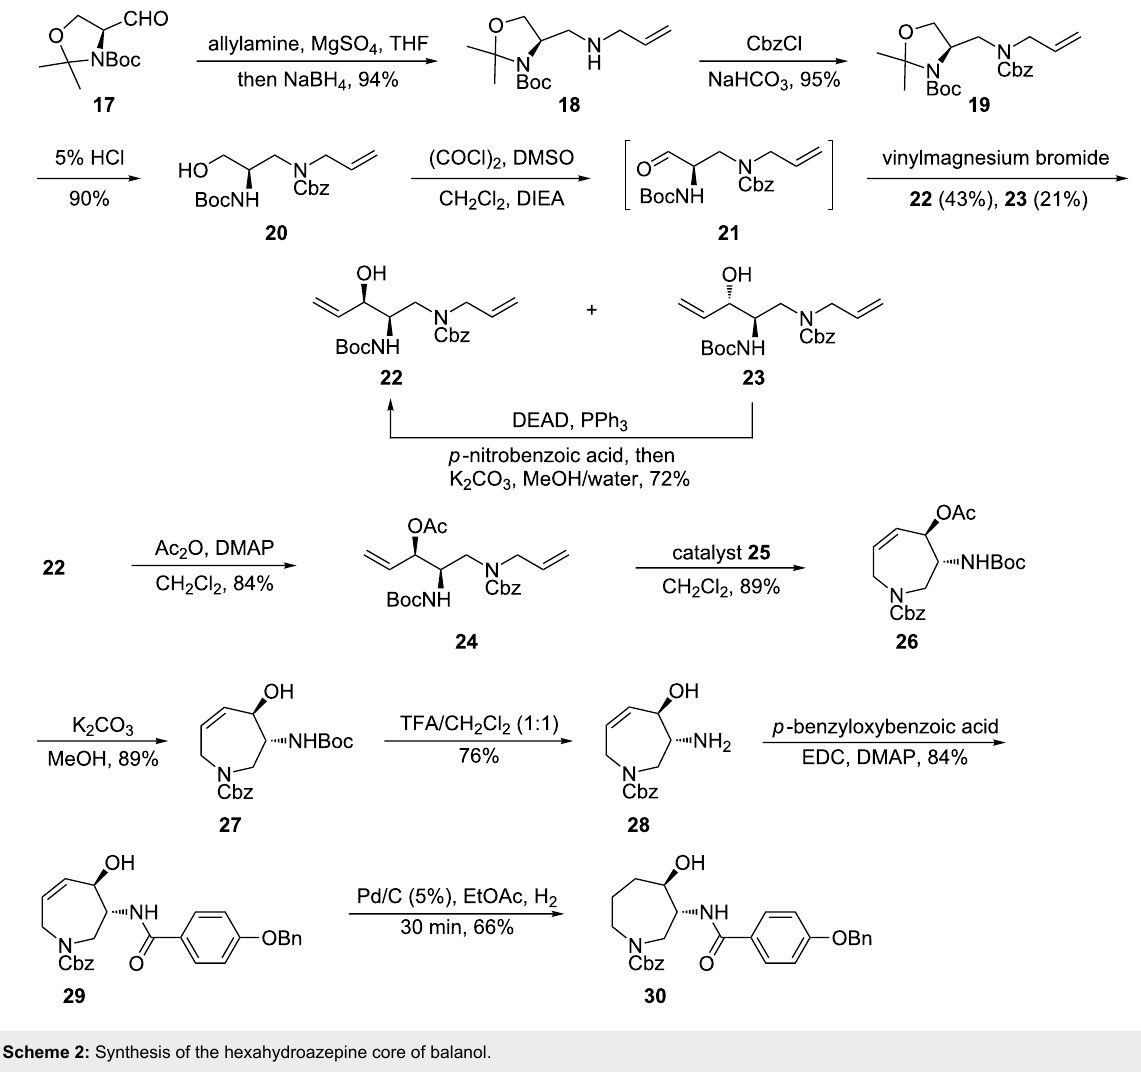
Scheme 2: Synthesis of the hexahydroazepine core of balanol.